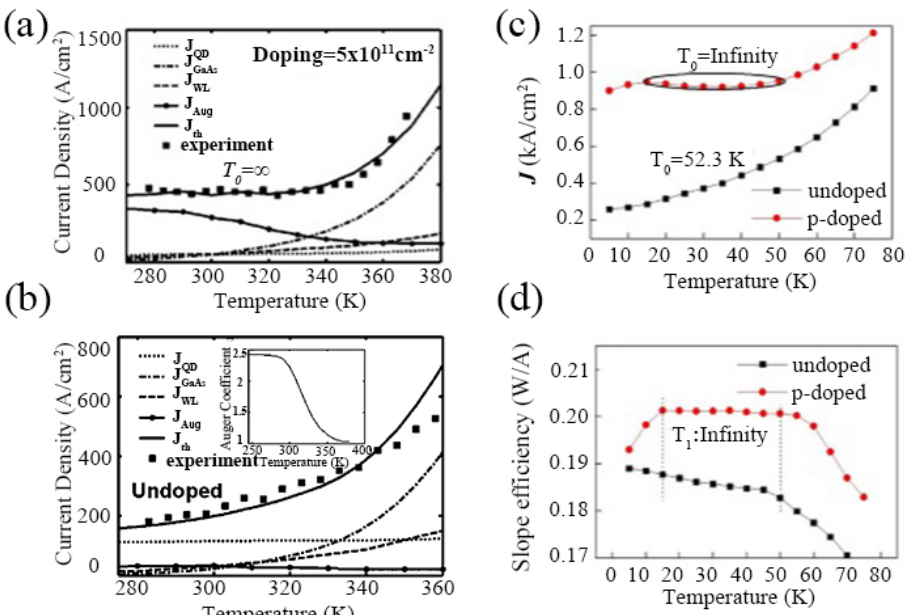
Figure 16. Variation of calculated and measured threshold current density in ( a ) QDP and ( b ) QDU lasers, respectively. Reproduced with permission from [32]. AIP Publishing, 2004. ( c ) Temperature dependences of threshold current density for QDU and QDP lasers. ( d ) Slope efficiency for QDU and QDP lasers. Reproduced with permission from [134]. Springer Nature, 2018.